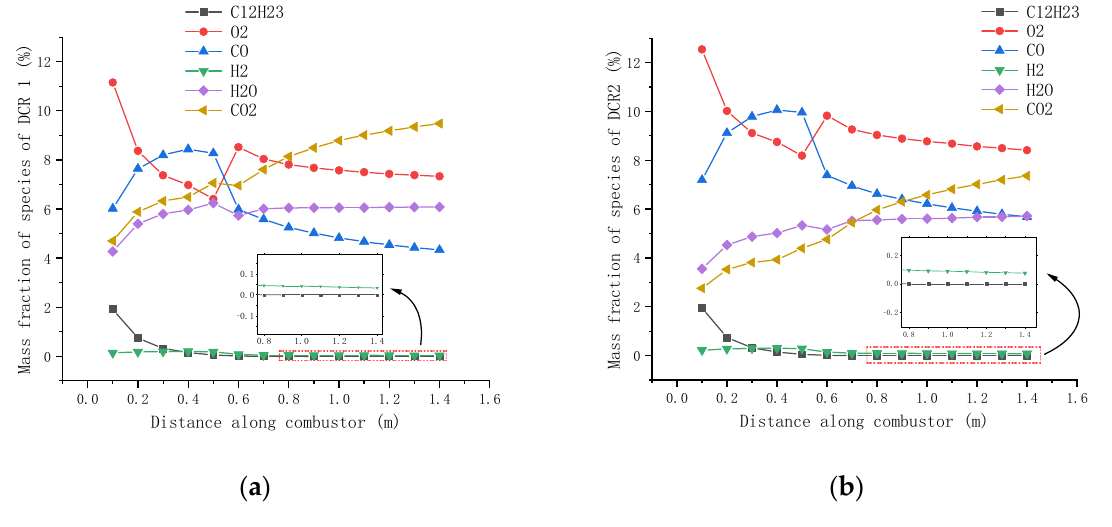
Figure 13. Species mass fraction for ( a ) DCR 1 and ( b ) DCR 2.